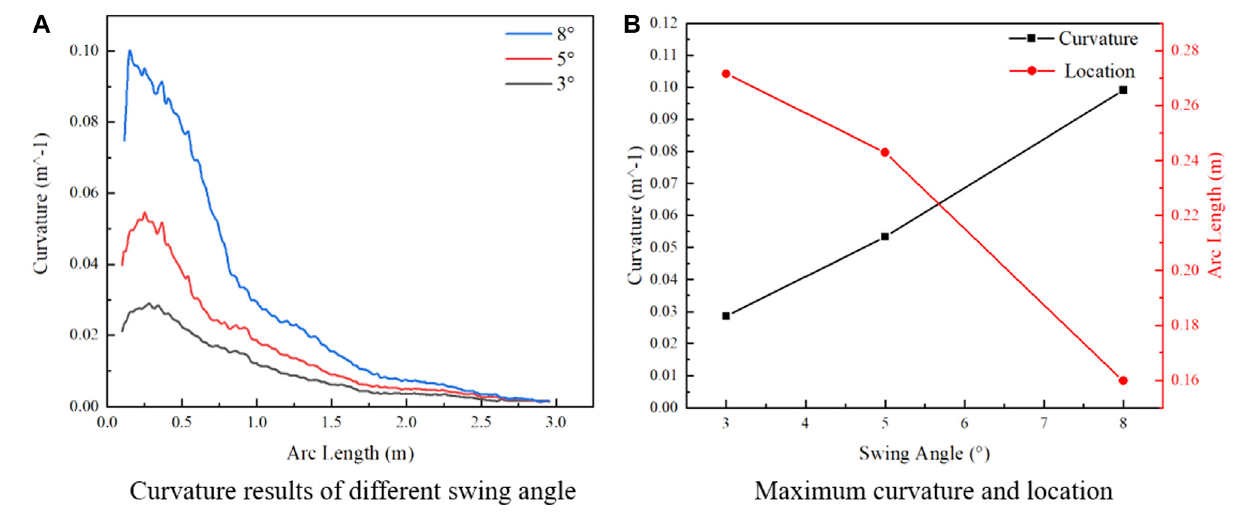
FIGURE 7 | Curvature results with different swing angle.